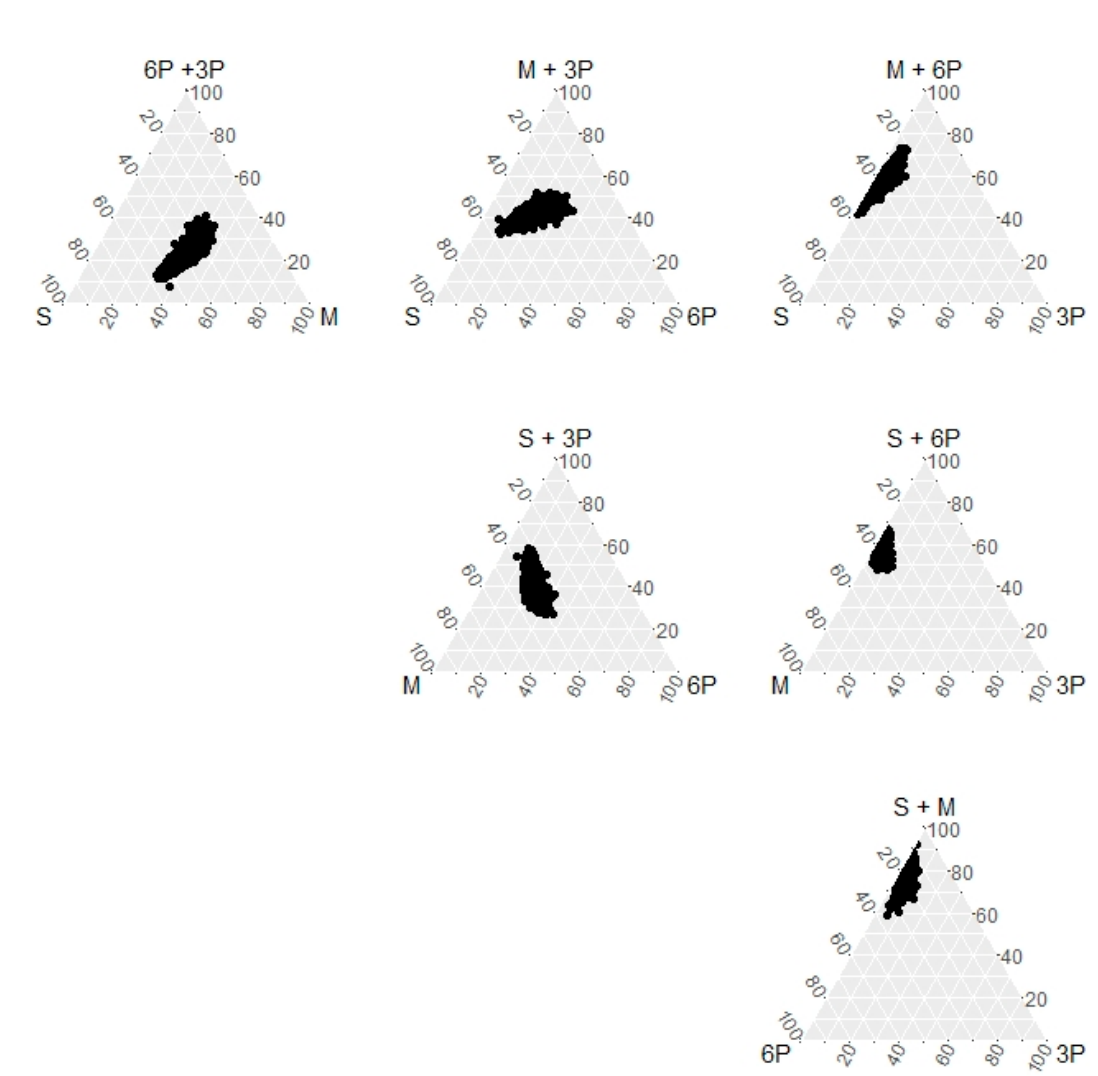
Figure 1. Ternary plot of fatty acids among saturated (S), monounsaturated (M), and omega-6 and -3 polyunsaturated (6P, and 3P, respectively) fatty acids. The top of the triangle indicates the sum of paired fatty acids. The scale indicates percentages of total fatty acids.